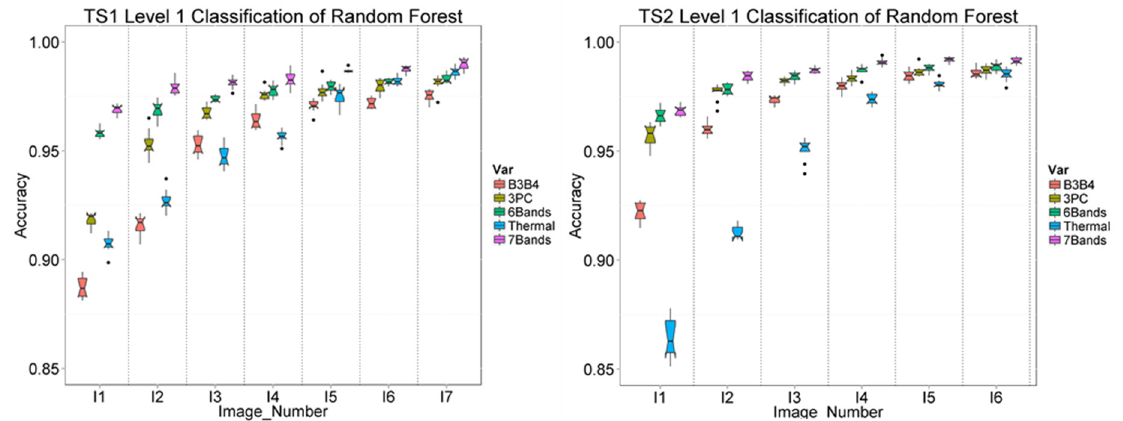
Figure 6. TS1 and TS2 boxplot of the 10-fold Level 1 classification overall accuracy variation by Random Forest for the time series images of the combination of band 3 and band 4 (B3B4), the first three principal components (3PC), the combination of 6 bands (6Bands), the thermal bands and the combination of 7 bands (7Bands).